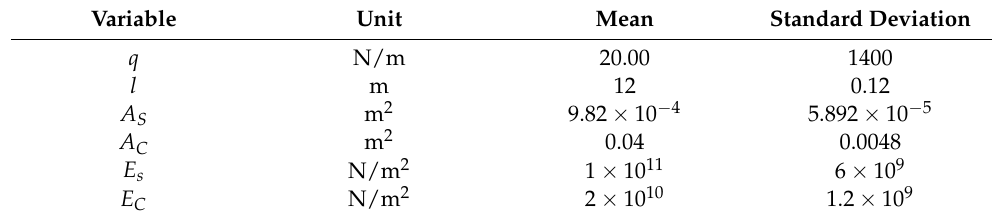
Table 5. Basic random variables in Example 3.